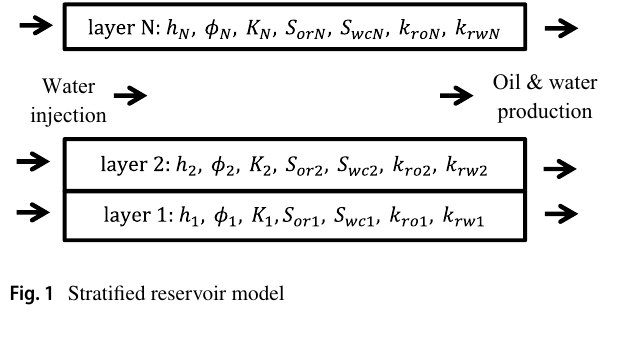
Fig. 1 Stratified reservoir